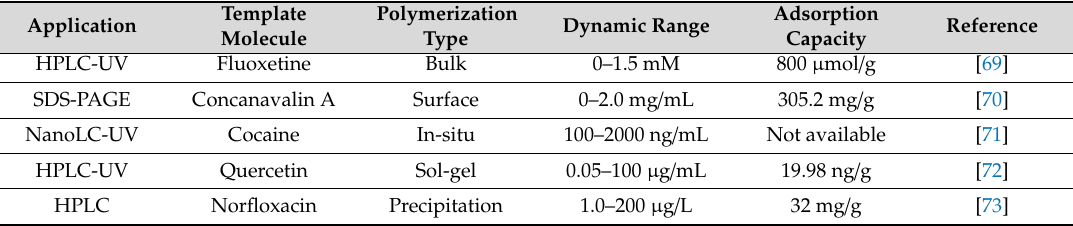
Table 2. Comparison of molecularly imprinted chromatographic